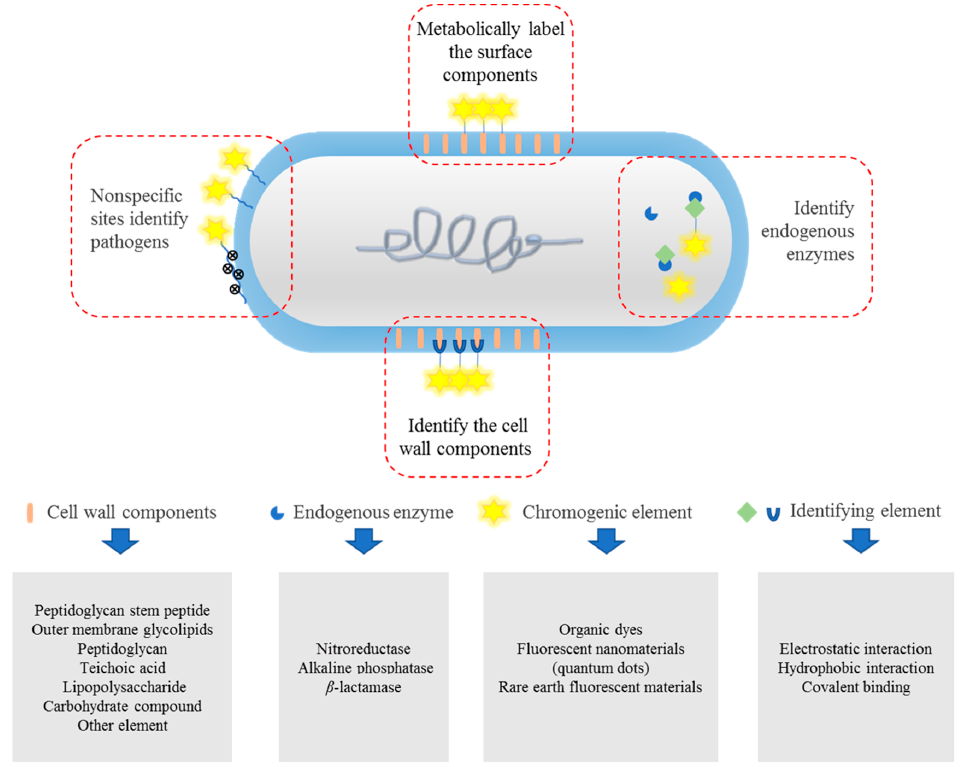
Figure 1. Pathogenic bacterial identification strategies using fluorescent